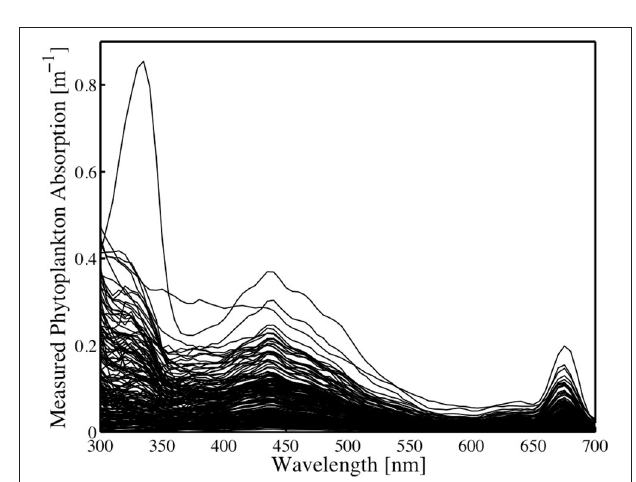
FIGURE 3 | In situ phytoplankton absorption (m − 1 ) from samples collected during the study.